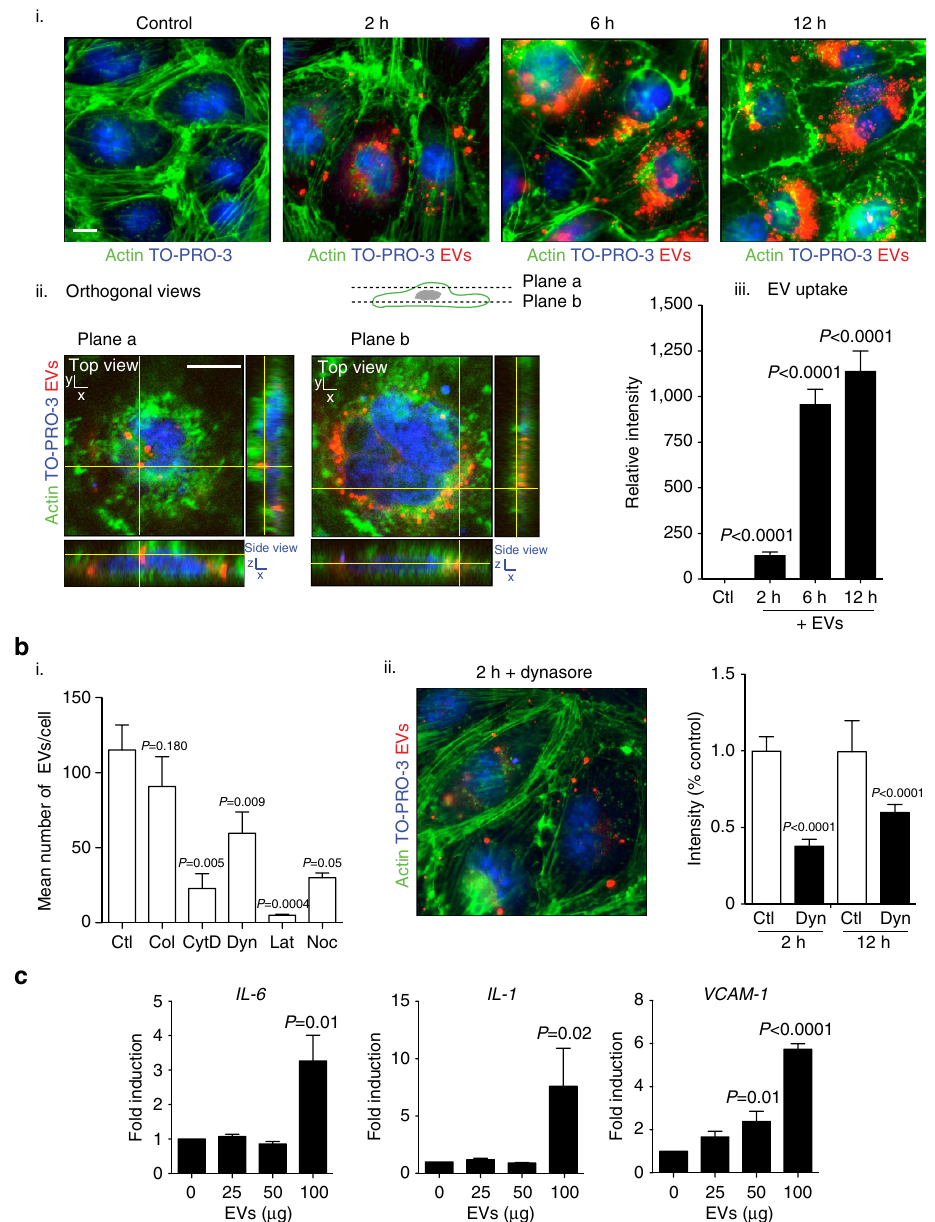
Figure 5 | Uptake of EVs by endothelial cells. ( a ) Dynamics of EV internalization. Bone marrow endothelial cells (BMEC) were incubated with 100 m g of PKH26 fluorescently labelled EVs for 0, 2, 6 or 12h. BMECs were stained for actin (phalloidin, green) and nuclei (TO-PRO-3, blue). (i) Following washing, the majority of internalized EVs were detected in a perinuclear region of the endothelial cell starting at 2h post incubation. Scale bar, 10 m m. (ii) Orthogonal views of a representative cell after 12h of EV uptake demonstrate that EVs are internalized. Scale bar, 7 m m. (iii) Internalized EVs were quantified by means of fluorescence intensity. Background signal was subtracted for every single image before obtaining the relative fluorescence per field. At least 15 images were collected per condition (mean ± s.e.m.; n ¼ 3 experiments). P versus control (Student’s t -test). ( b ) Effect of inhibitors on EV uptake. Cells were co-incubated with inhibitors and EVs, uptake was quantified compared with control as in a . (i) Effect of known EV uptake inhibitors. Compounds were co-incubated for 2h with EVs and the effect measured as mean number of EVs per cell. Ctl: control. Col: Colchicine (31nM). CytD: Cytochalasin (600nM). D. Dyn: Dynasore (80 m M). Lat: Latrunculin A (5 m M). Noc: Nocodazole (20 m M). (ii) Phenotypic effect of Dynasore inhibition. The drug was added at 80 m M and the effect measured (intensity of PKH26 staining) after 2 and 12h of co-incubation with EVs. (mean ± s.e.m.; n ¼ 3 experiments). P versus control (Student’s t -test). ( c ) Activation of cytokines and cell surface receptors upon EV uptake. Detection of IL-1 , IL-6 and VCAM-1 by qRT-PCR in BMEC upon incubation with an increasing amount of EVs. qRT-PCR results are normalized by the 2 -Ct method, using EF-1 as a reference and expressed as mean and fold induction over control (mean ± s.e.m.; n ¼ 3 experiments), P versus control (Student’s t